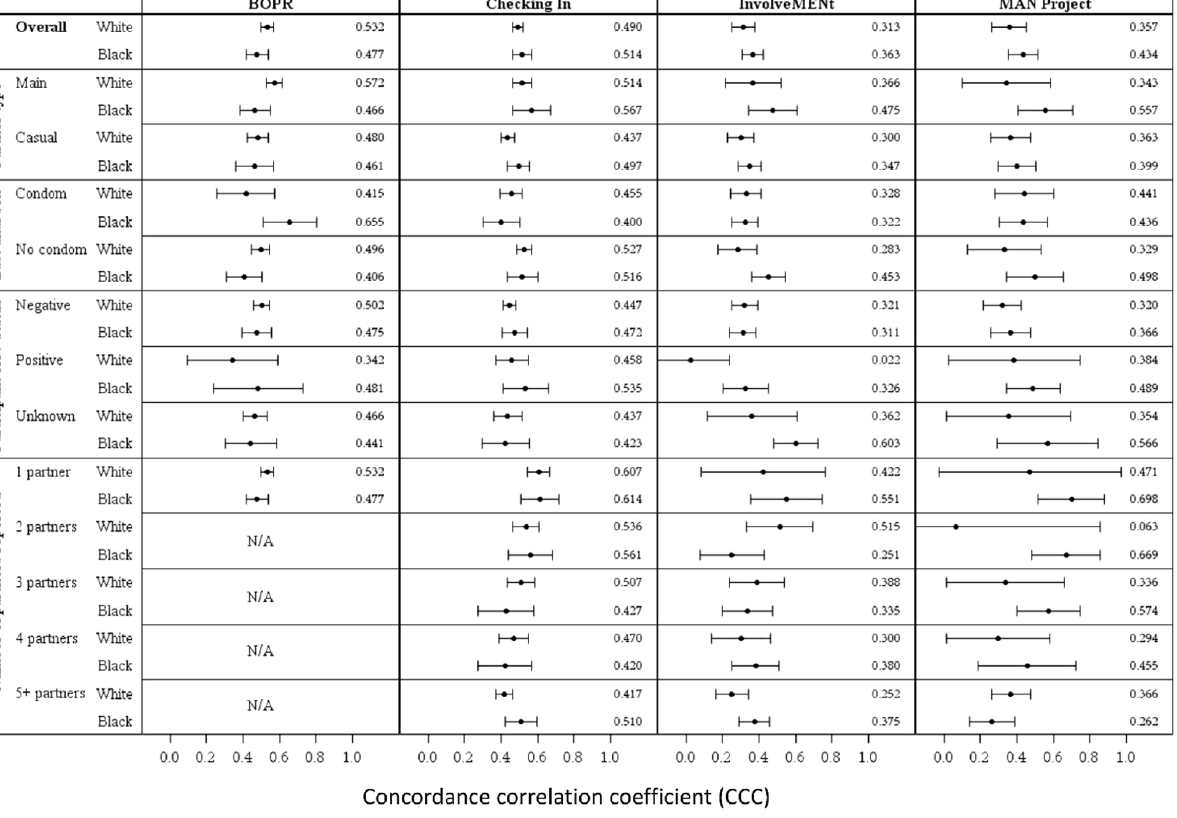
Fig 1. Concordance correlation coefficients for participant and partner age, by study, race and select characteristics. Note: CCCs are depicted with 99% confidence intervals. Point estimates are listed on the right side of each cell. Although values range from -1 to 1, only the range from 0 to 1 is depicted.